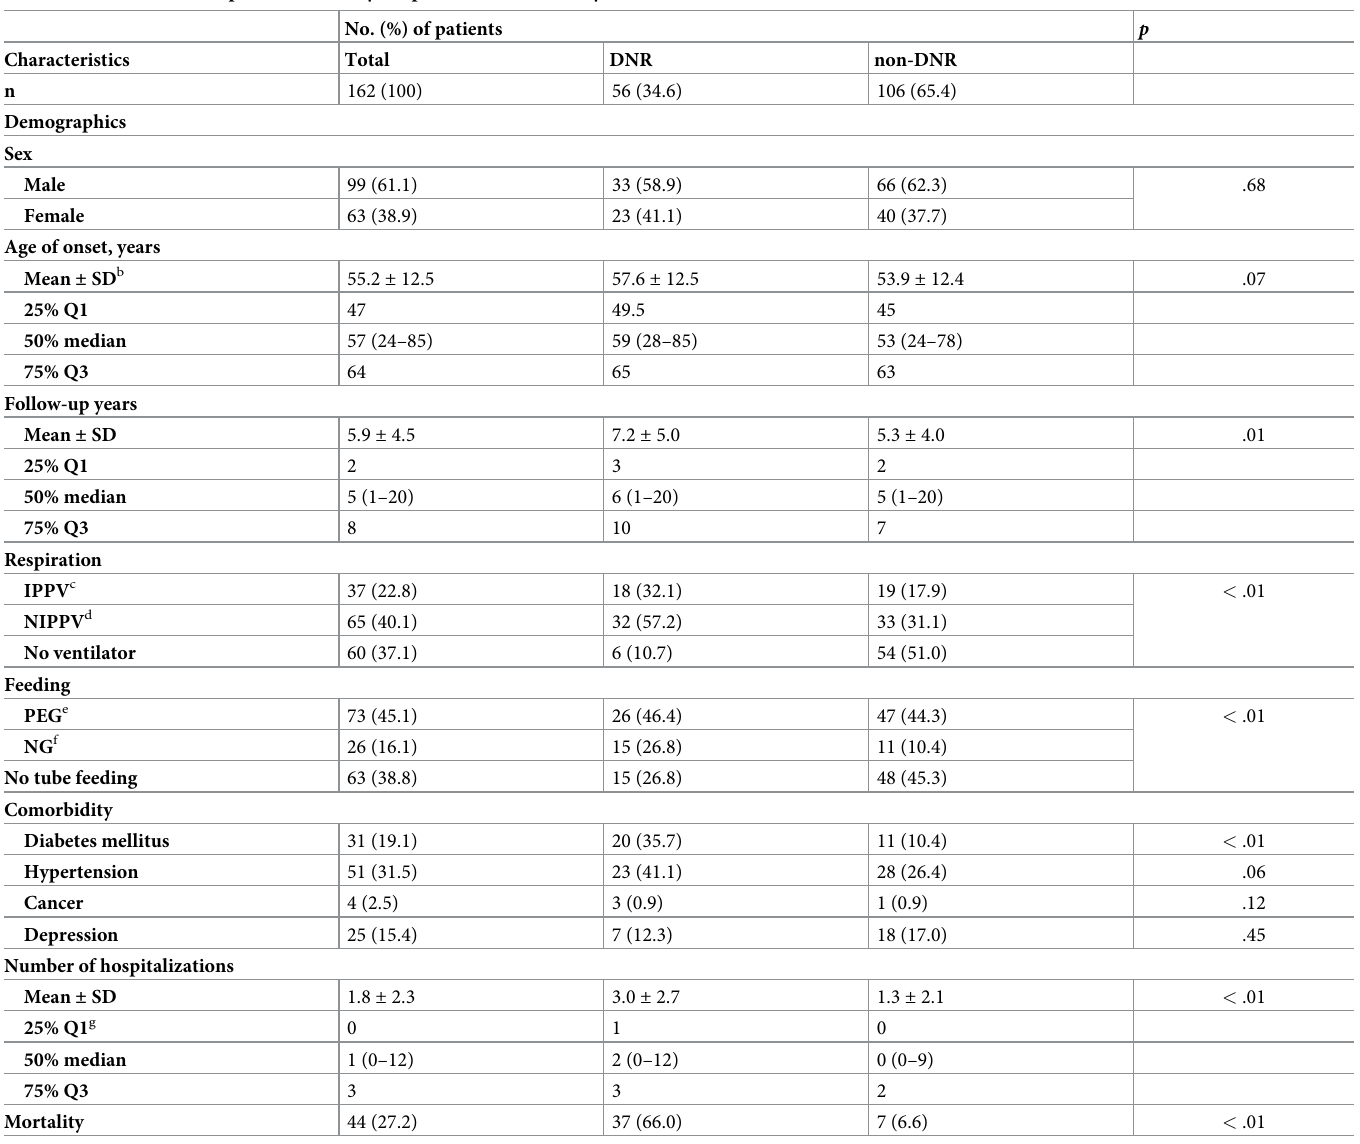
Table 1. Characteristics of patients with amyotrophic lateral sclerosis by DNR a . No. (%) of